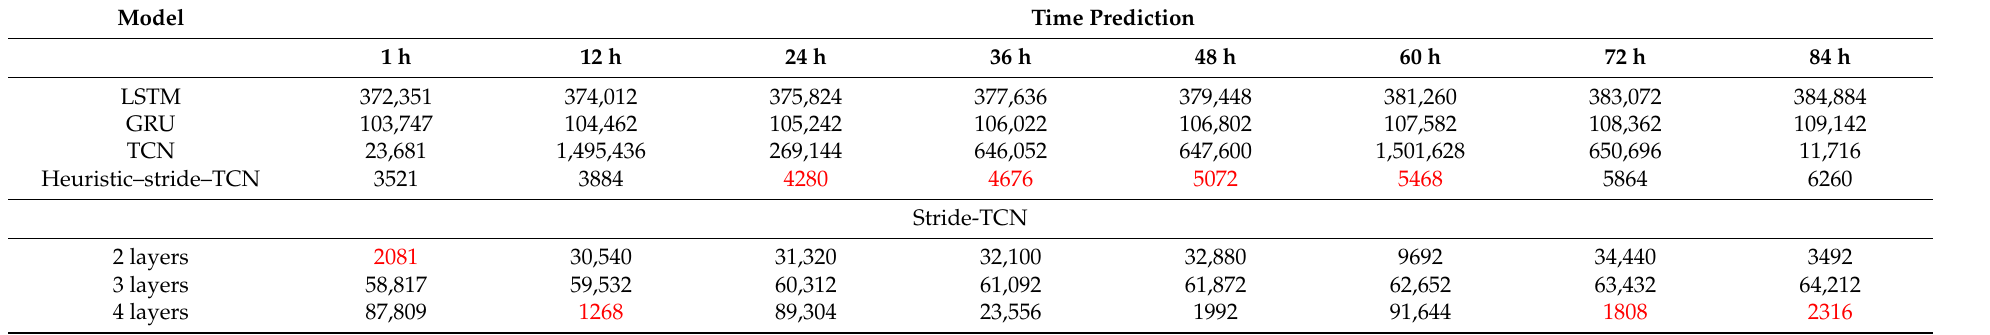
Table 8. Models’ complexity in the Household dataset (dataset 1), demonstrated by the number of